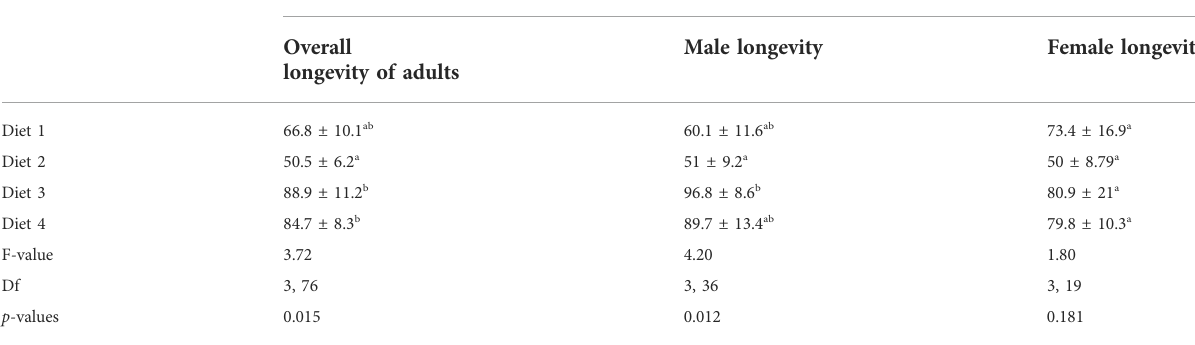
TABLE 7 Mean (±SE) overall adult longevity and adult longevity by sex of Ruspolia differens reared on various